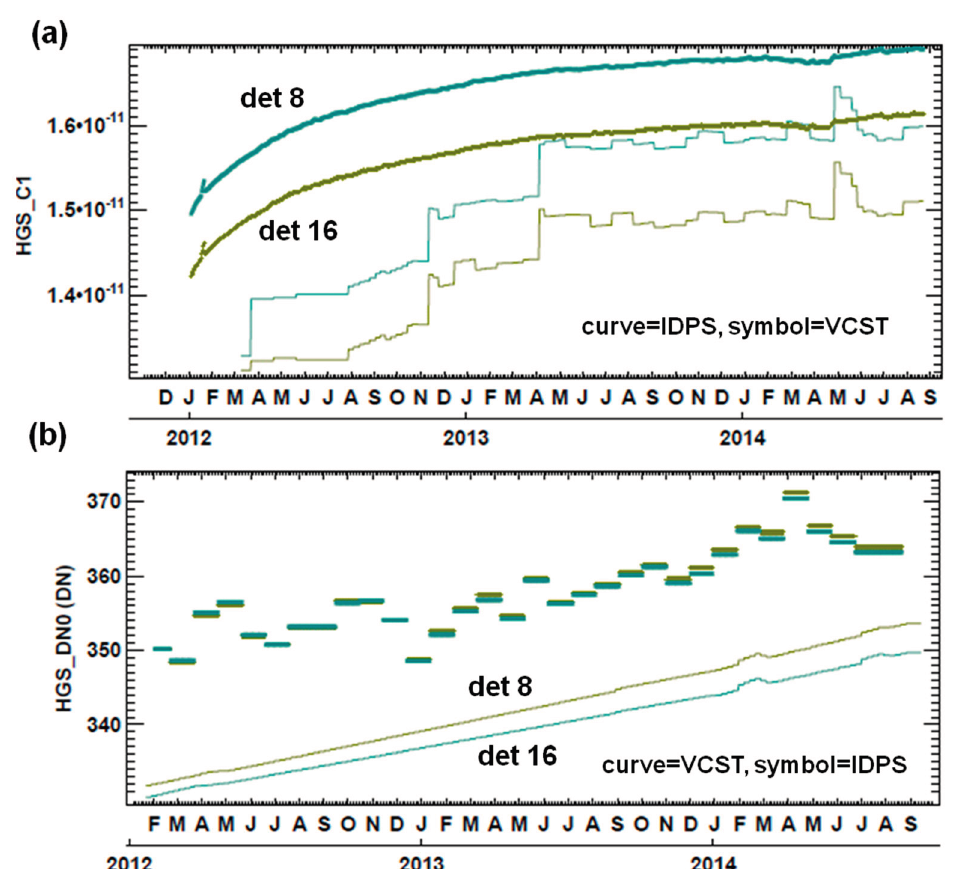
Figure 7. Comparison of daily average HGS gain and offset values between NASA and IDPS. ( a ) HGS gain coefficients (HGS_C1), in units of W·cm − 2 ·sr − 1 ; ( b ) HGS offset (HGS_DN0) in DNs. The plots show aggregation Mode 1, Detectors 8 and 16 as an